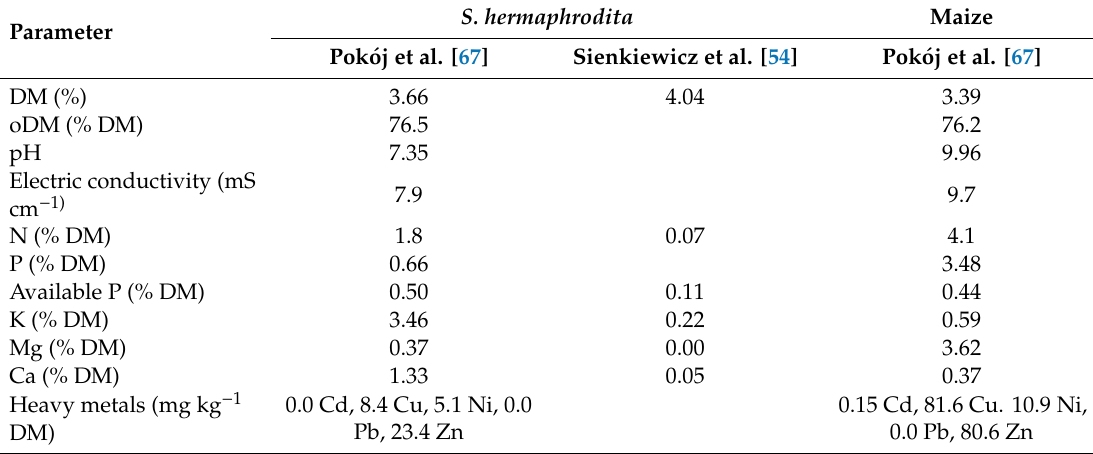
Table 9. Physicochemical composition of digestates from S. hermaphrodita and maize. S. hermaphrodita Parameter